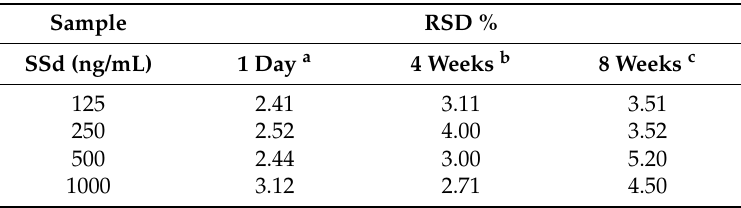
Table 3. Variations among ICS used for the analysis of SSd.